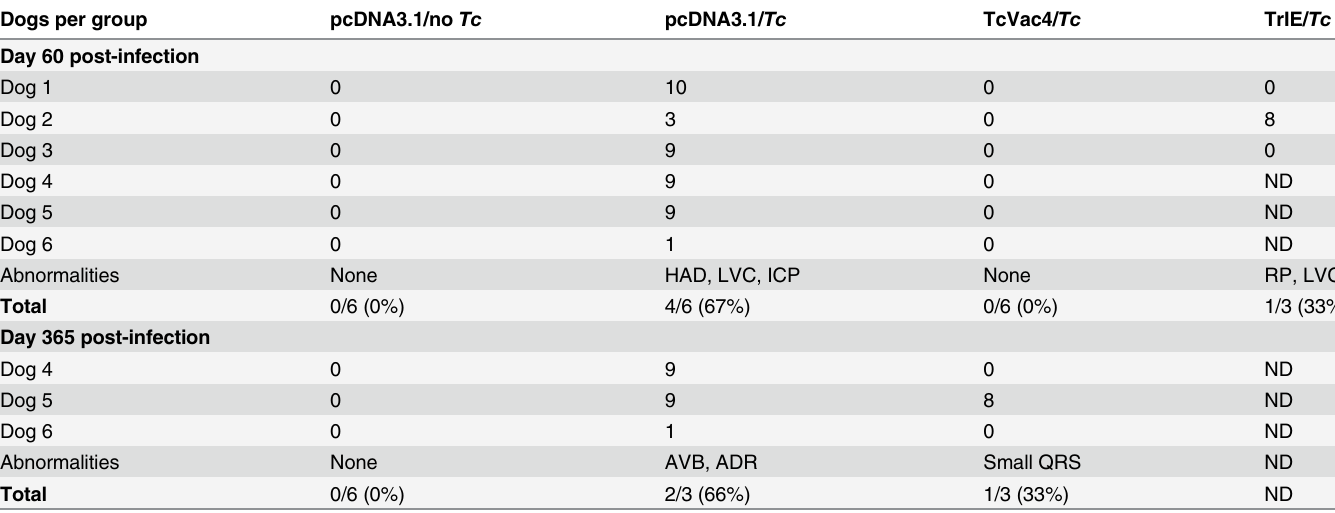
Table 1. Electrocardiographic evaluation of TcVac4-immunized dogs post challenge infection with T . cruzi . Dogs per group pcDNA3.1/no Tc pcDNA3.1/